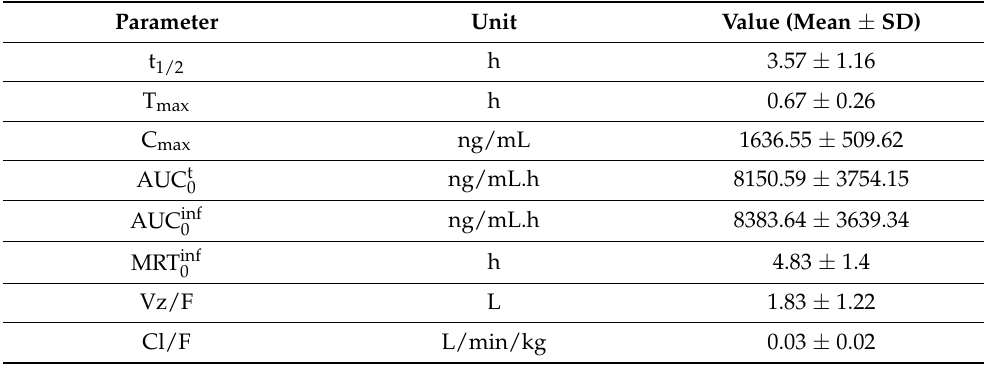
Figure 5. Plasma concentration–time profile of capmatinib after a single oral dose of 10 mg/kg in male SD rats ( n = 6). The data are expressed as mean ± SD. Table 7. Capmatinib pharmacokinetic parameters after the administration of a single oral dose of 10 mg/kg in SD